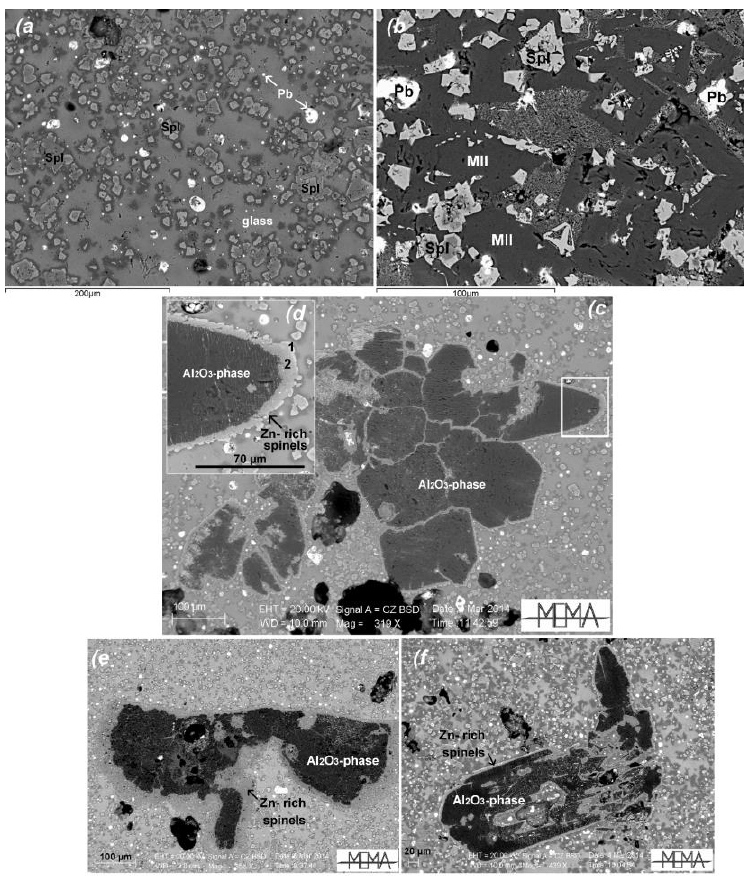
Figure 6. BSE images of matte poor slags (I) from Montieri: ( a ) panoramic view with glass, zoned spinels, and metallic lead (white droplets); ( b ) melitites and zoned spinels; ( c , d ) images of Al 2 O 3 - phase inclusions rimmed by spinels with (1) white Fe-rich rim, (2) grey Zn-rich rim; ( e , f ) images of Al 2 O 3 -phase inclusions rimmed by spinels. Abbreviations: Mll—melilites; Spl—zoned spinels.